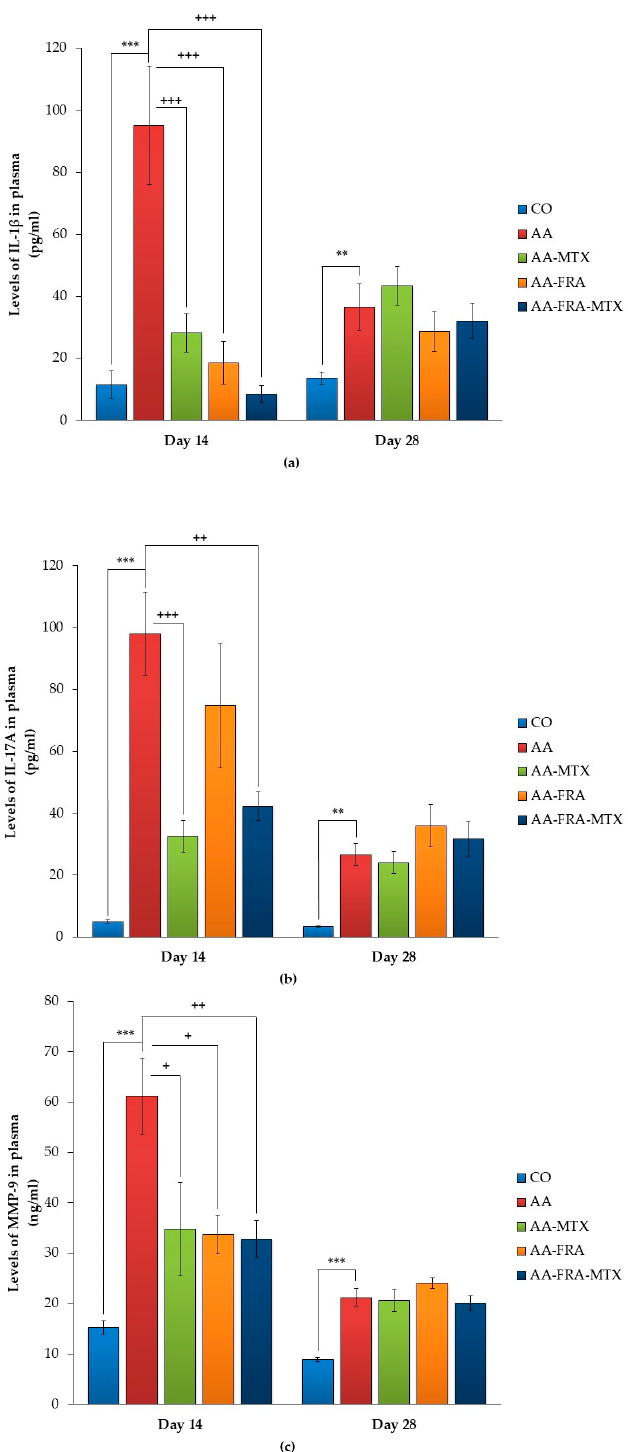
Figure 2. Effect of FRA and MTX administered alone or in combination on the levels of IL-1 β ( a ), IL-17A ( b ), and MMP-9 ( c ) in plasma on experimental days 14 and 28. CO, control group; AA, adjuvant arthritis group; AA-FRA, adjuvant arthritis group administered ferulaldehyde; AA-MTX, adjuvant arthritis group administered methotrexate; AA-FRA-MTX, adjuvant arthritis group administered ferulaldehyde and methotrexate. The data represent the mean ± SEM; n = 7–8. The symbols *, + and # show significant difference: ** p < 0.01 vs. CO; *** p < 0.001 vs. CO; + p < 0.05 vs. AA; ++ p < 0.01 vs. AA; +++ p < 0.001 vs. AA.